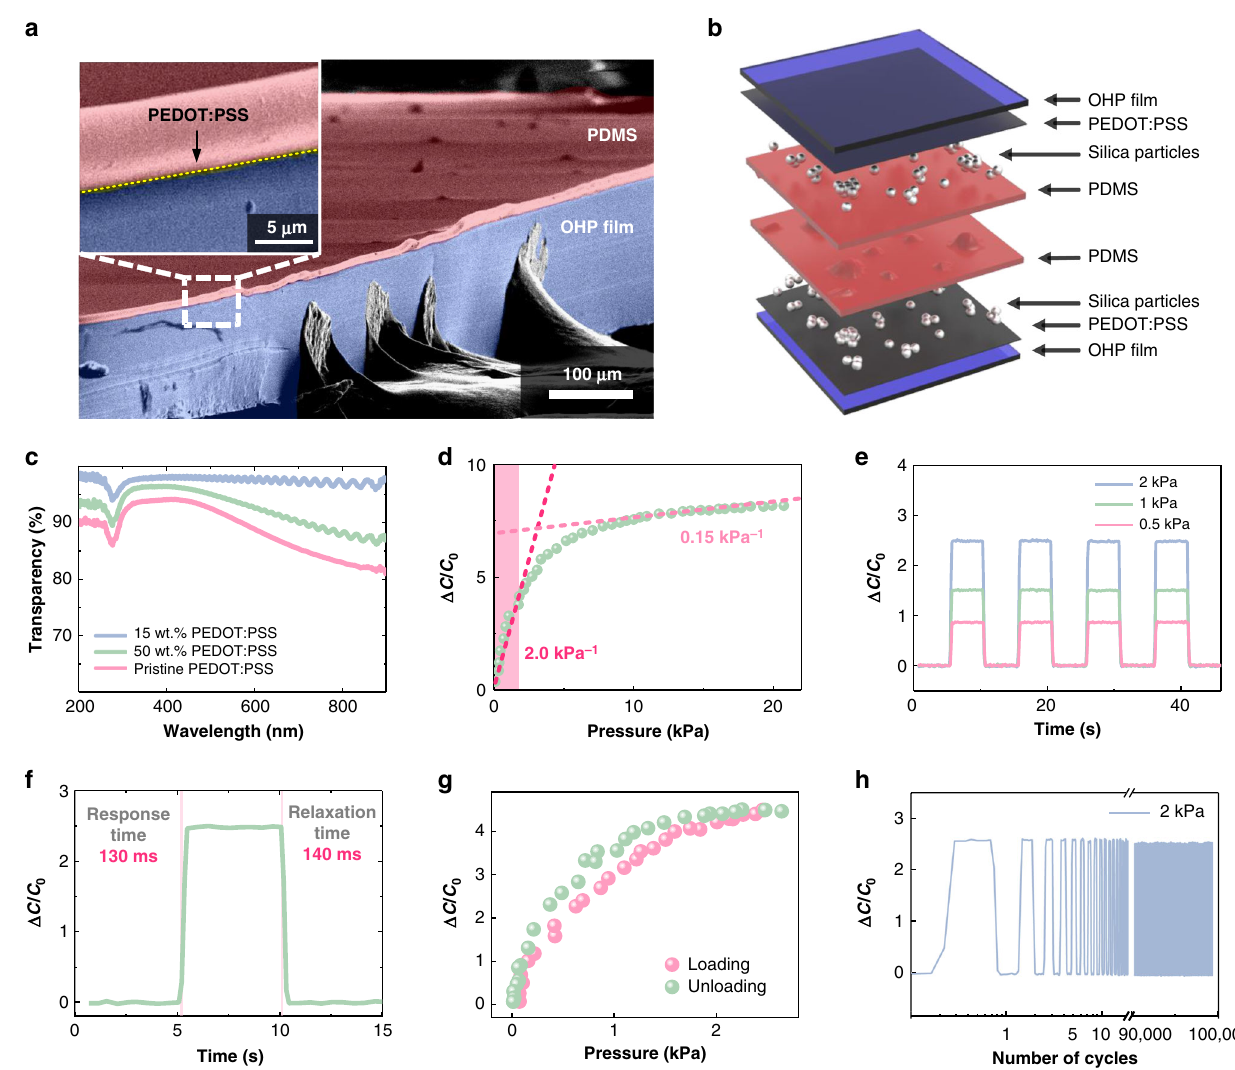
Fig. 4 Structure and sensing capabilities of demonstrated capacitive pressure sensor. a Tilted-view scanning electron microscopy (SEM) image of sensor layer. b Schematic of capacitive pressure sensor consisting of 500-nm diameter silica nanoparticles dispersed in poly(dimethylsiloxane) (PDMS)/poly(3,4- ethylenedioxythiophene):-poly(styrenesulfonate) (PEDOT:PSS) layers on overhead projector (OHP) fi lm substrate. c Measured transparency as a function of light wavelength from 200 to 900 nm for different concentrations of PEDOT:PSS/ethanol solution spin-coated onto the sensor layers of OHP substrates. d Capacitive response for a pressure of 0 – 20 kPa applied to the capacitive pressure sensor. e Time-resolved capacitive response of a sensor under repeated normal pressure values of 0.5 (red line), 1 (green line), and 2 kPa (blue line). f Response and relaxation time after loading (2 kPa for 5 s)